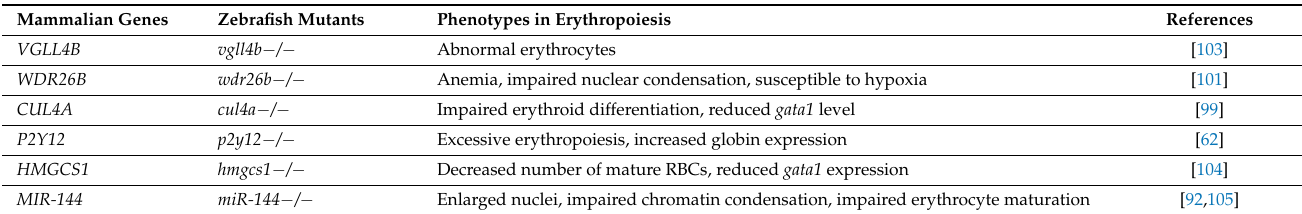
Table 1. Recently generated zebrafish mutants with defective